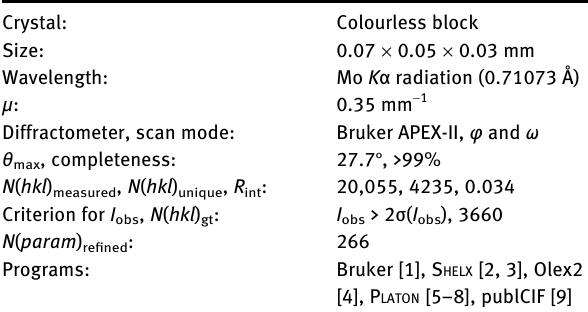
Table  : Data collection and